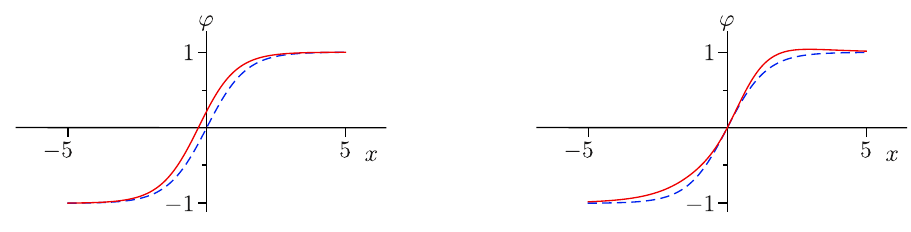
Figure A.1: The spatial profiles of the field ϕ ( t , x ) for kinks with the internal excita- tions of Eq. (A.8). The dashed blue lines show a static kink solution. The red line in the left panel adds a zero-energy translational excitation to the kink, while the red line in the right panel shows the excitation of the internal vibrational mode of the